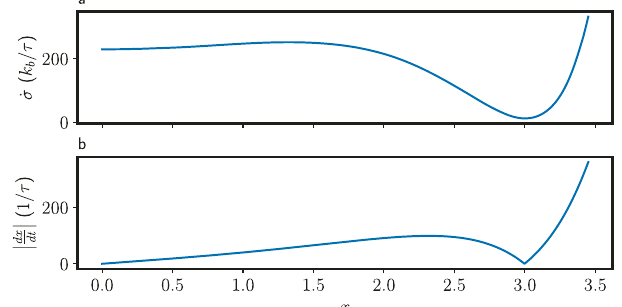
Fig. 3 | Entropy production rate and speed along deterministic trajectories. a Deterministic entropy production rate _ σ , and ( b ) deterministic speed ∣ dx / dt ∣ as a function of x for V dd =3 (see the Supplementary Note 1 for the de fi nition of the timescale τ